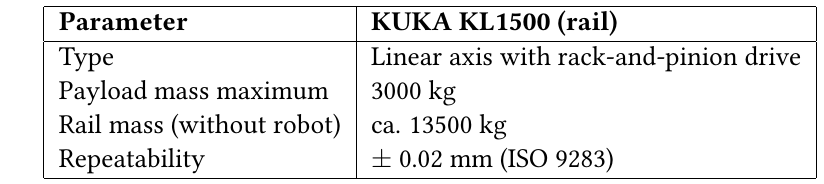
Table 1: Technical data of the rail.